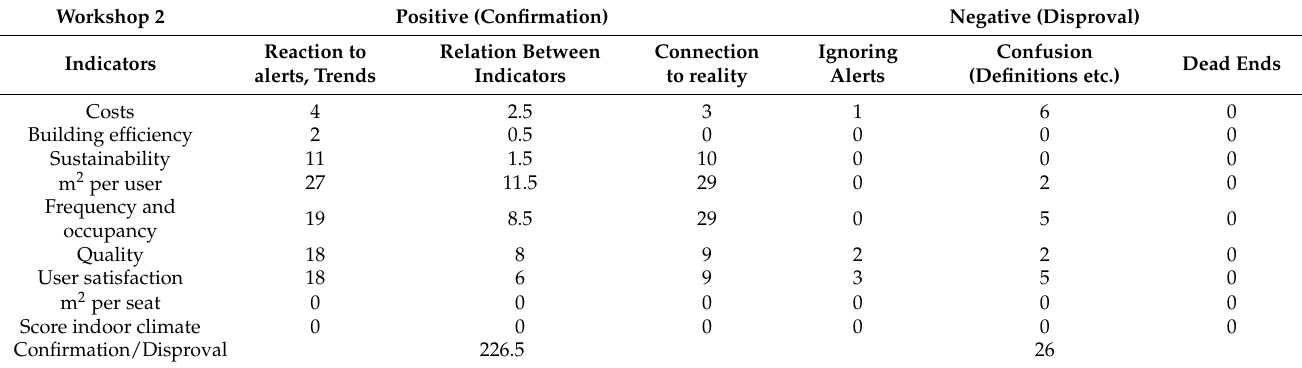
Table A4. Positive and negative interactions of users with the dashboard in workshop 2 (TU